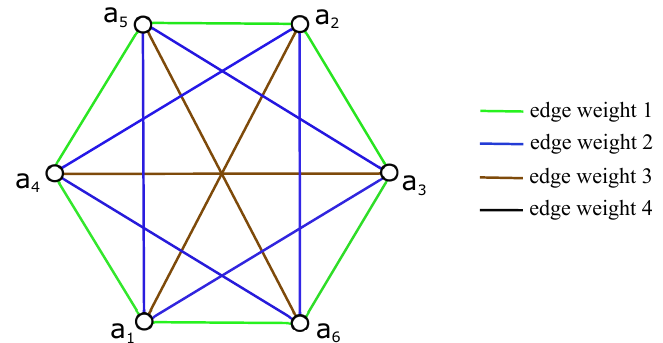
Figure 3. Representation of lower bounds of Table 1 by the graph G = ( V , E , w )